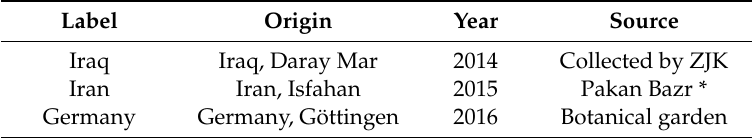
Table 1. Hyoscyamus niger.